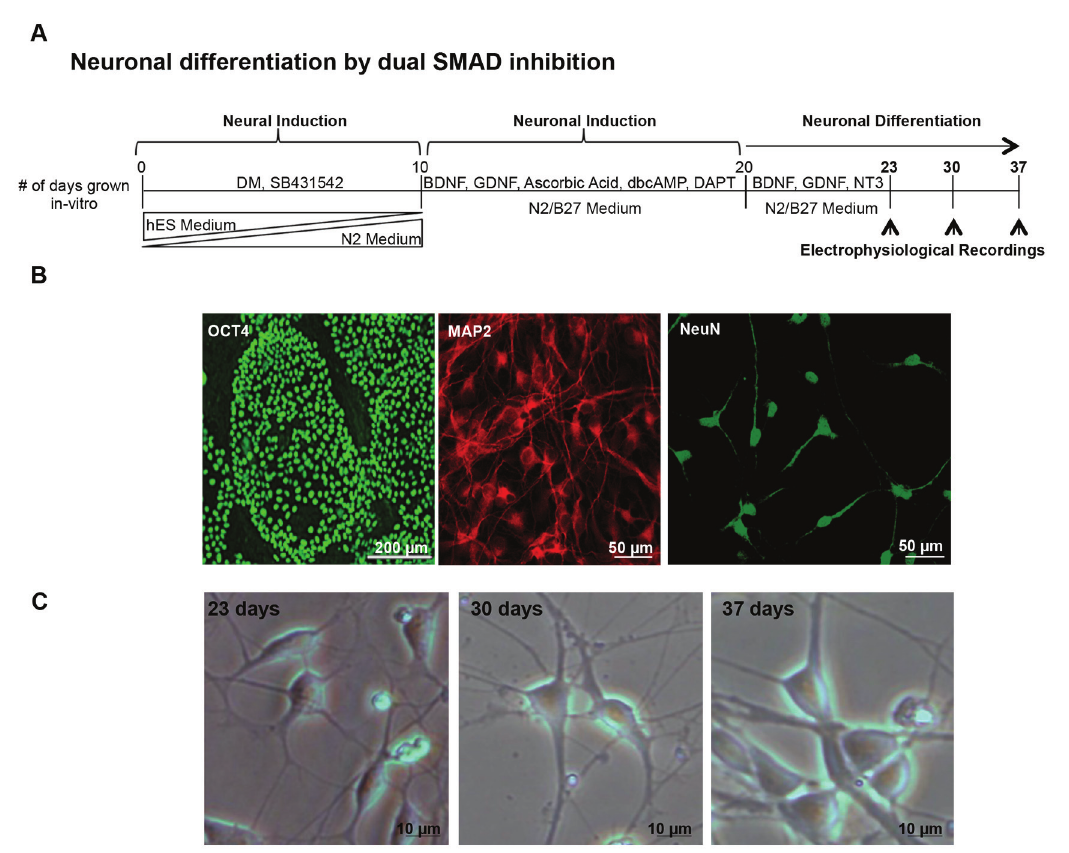
Figure 1. Neuronal differentiation of human embryonic stem cells by dual SMAD inhibition. ( A ) Schematic representation of the protocol for in-vitro neural differentiation using dual SMAD inhibition. The protocol includes 3 steps: 1) Neural induction (days 0–10), by blocking SMAD signaling using Dorsomorphin (DM) and the TGF- β inhibitor SB431542 while reducing the relative amounts of hES medium and concomitantly increasing the relative amounts of N2 medium. 2) Neuronal induction (days 10–20), by incubating cells with brain-derived neurotrophic factor (BDNF), glia-derived neurotrophic factor (GDNF), ascorbic acid, dibutyryl-cyclic-AMP (dbcAMP) and the NOTCH1-inhibitor DAPT; 3) Neuronal differentiation (days 20–37), by dissociating cells and re-plating them on poly-lysine/laminin-coated glass coverslips in the presence of BDNF, GDNF and neurotrophin 3 (NT3). The specific time-points for electrophysiological recordings are indicated with arrows. ( B ) Representative images of HUES-13 hESC line undifferentiated colonies stained positive for OCT4 (green); hESCs-derived neurons at day 21 stained positive for MAP2 (red) and hESCs-derived neurons at day 37 stained positive for NeuN (green). ( C ) Bright field representative images of neurons at days 23, 30 and 37 of in-vitro neural